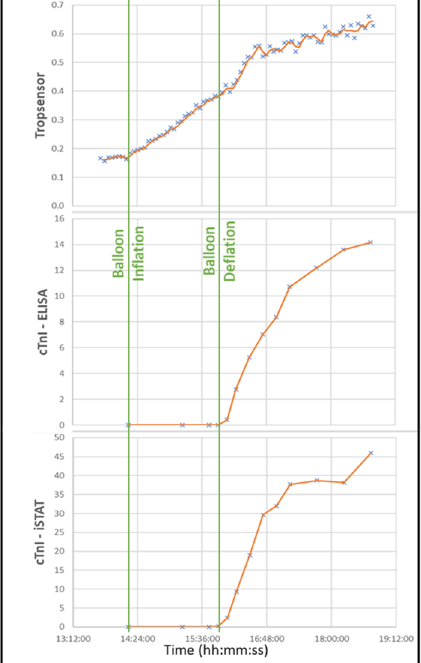
Figure 4. Real-time temporal correlation of the Tropsensor output with ELISA-based high sensitivity cardiac troponin 1 and IDEXX traditional cardiac troponin 1 measurements. The presence of infarction was confirmed by ST-segment elevation in EKGs performed at the set time points. When the LAD occlusion was resolved (balloon deflation), the influx of blood caused an increase in the troponin reading in all methods. cTn1, cardiac troponin 1.